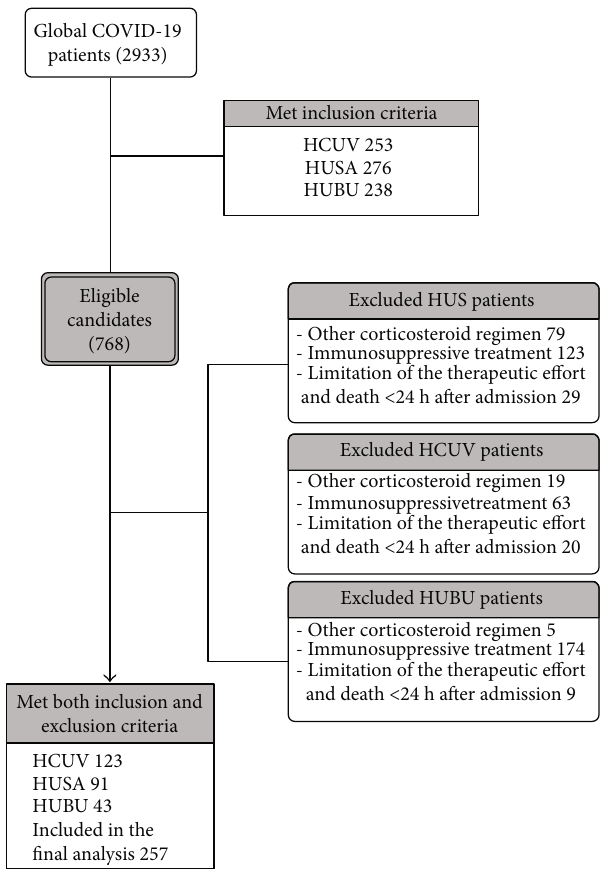
Figure 1: Flow diagram of COVID-19 included patients in this